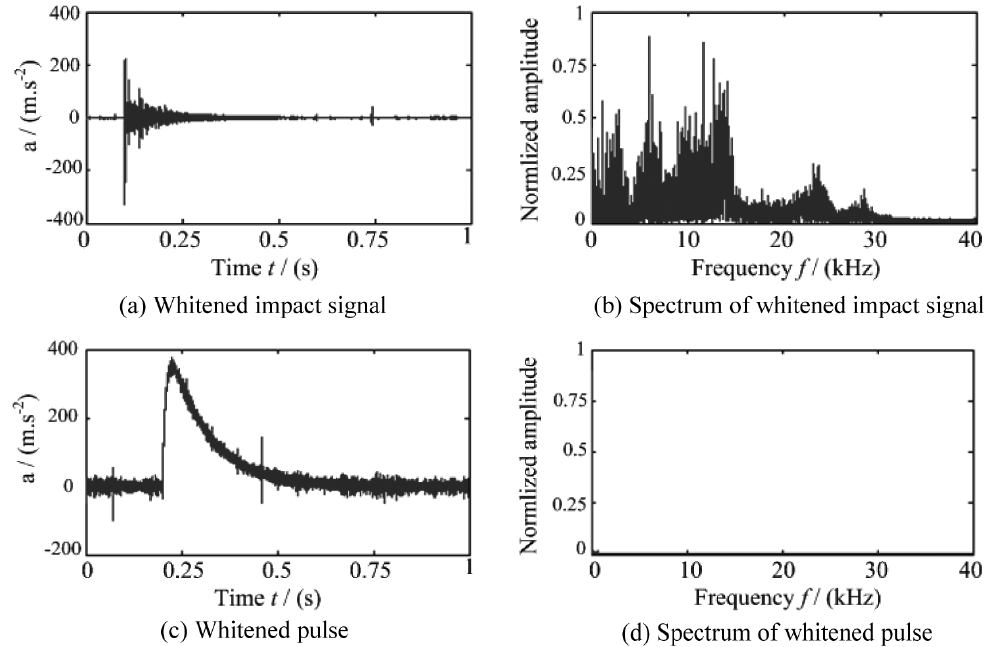
Fig. 6. Pulse signal with noise and its normalized spectrum after whitening (10 dB).